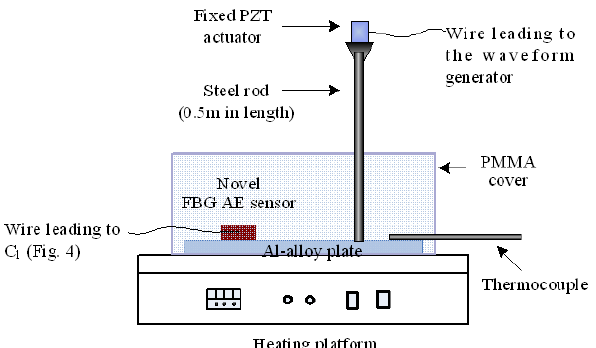
Fig. 7 Side view of the high temperature test